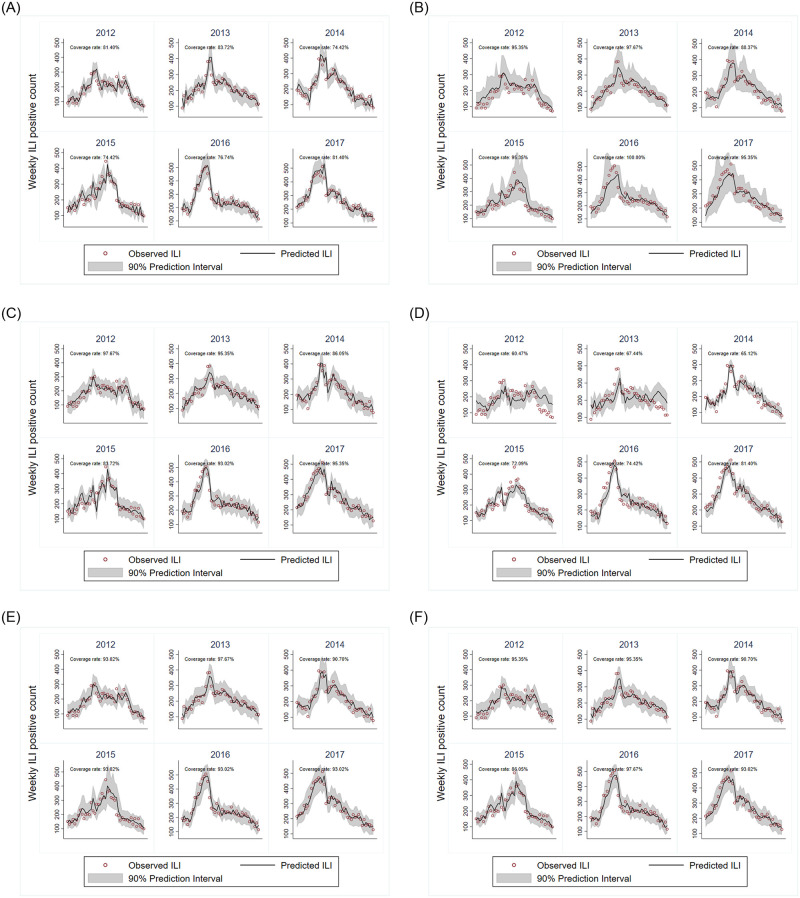
Predicted vs observed ILI visits for 1 week forecast.A: Empirical Bayes. B: Quantile Regression Forest. C: Linear Regression. D: ARIMA. E: Stacked Ensemble. F: Naive Ensemble.